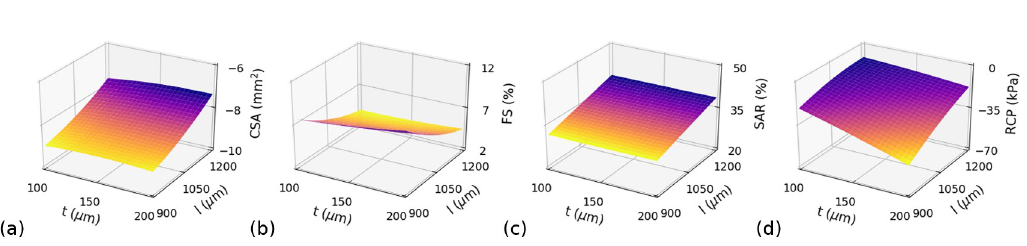
Fig 13. Response surfaces highlighting the combined influence of w and l on each performance metric (CSA, FS, SAR and RCP), holding A their baseline values ( A r = 1.35 and t = 150 μ m).